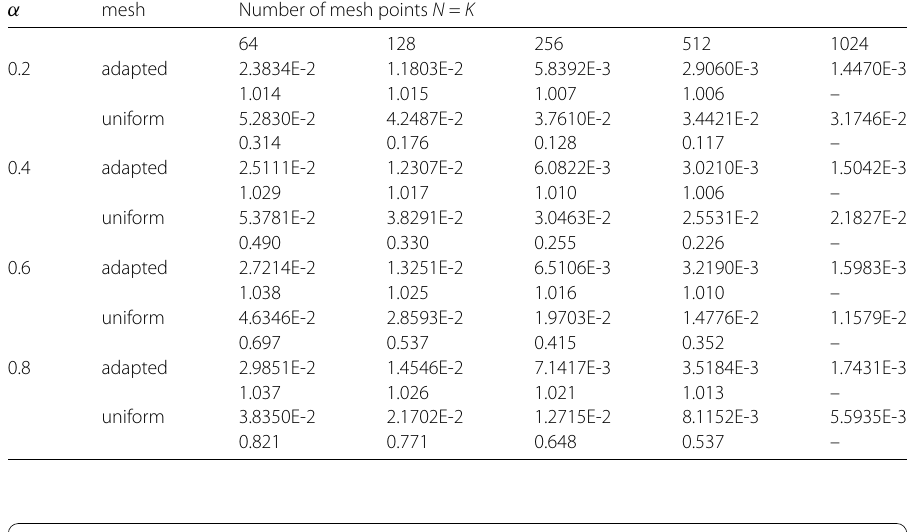
Table 2 Error estimates and convergence rates for Example 5.2